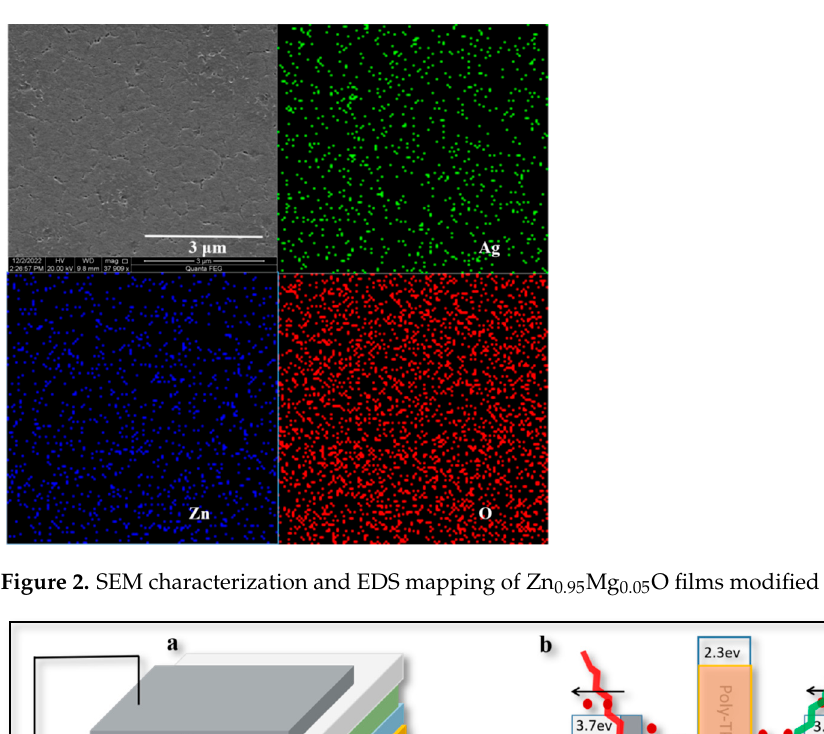
0.95 Mg 0.05 O films modified by Ag NPs.